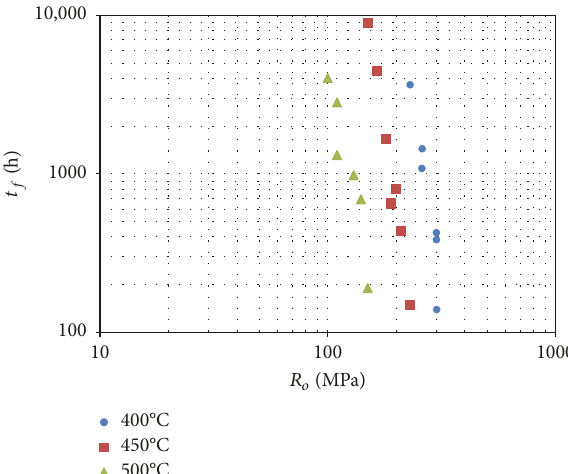
Figure 5: Ratio of 𝑅 𝑚𝑇 10 4 temperature function of tested steels and of selected creep-resistant